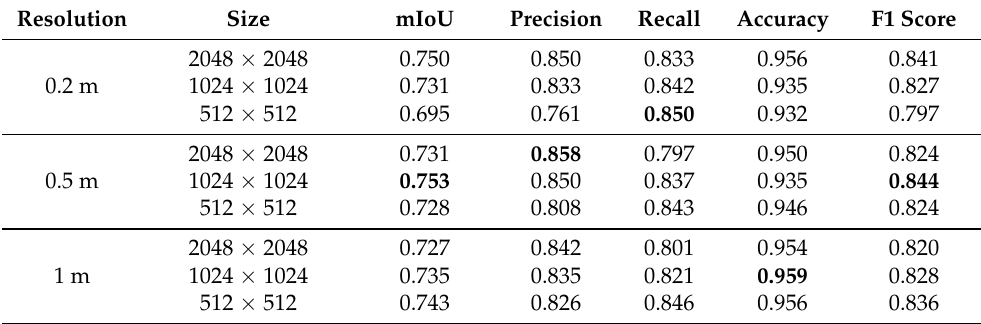
Table 3. Comparison of segmentation accuracy for SegFormer under different image resolutions and input